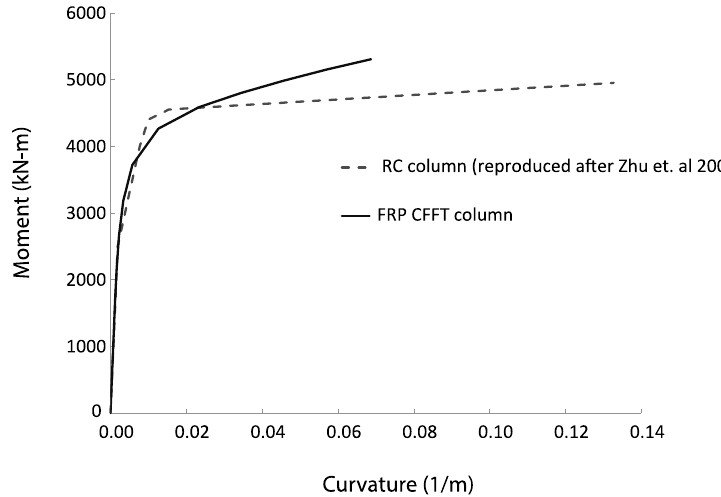
Figure 5. A comparison of the moment-curvature plot of a concrete-filled, fiber-reinforced polymer tube (FRP-CFFT) column (at an initial concrete compression stress of 45% f ’ c ) with a reinforced concrete (RC) column reproduced from Zhu et al. [27].